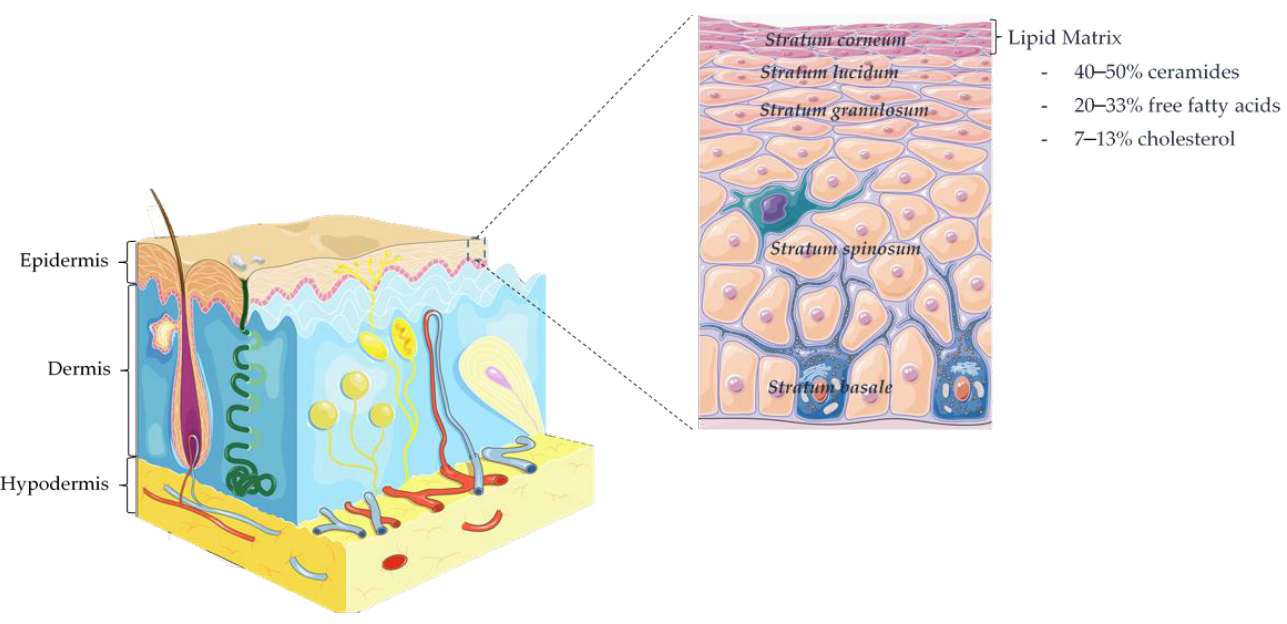
Figure 1. Schematic representation of skin layers and epidermis